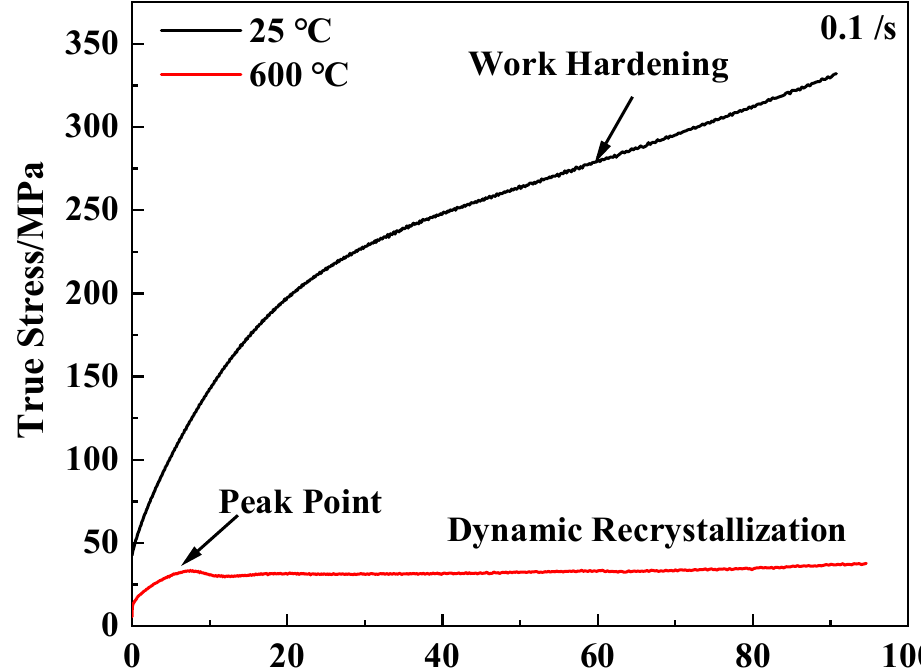
Figure 2. Stress-strain curves of high-purity Ag under different temperatures at 0.1 s − 1.